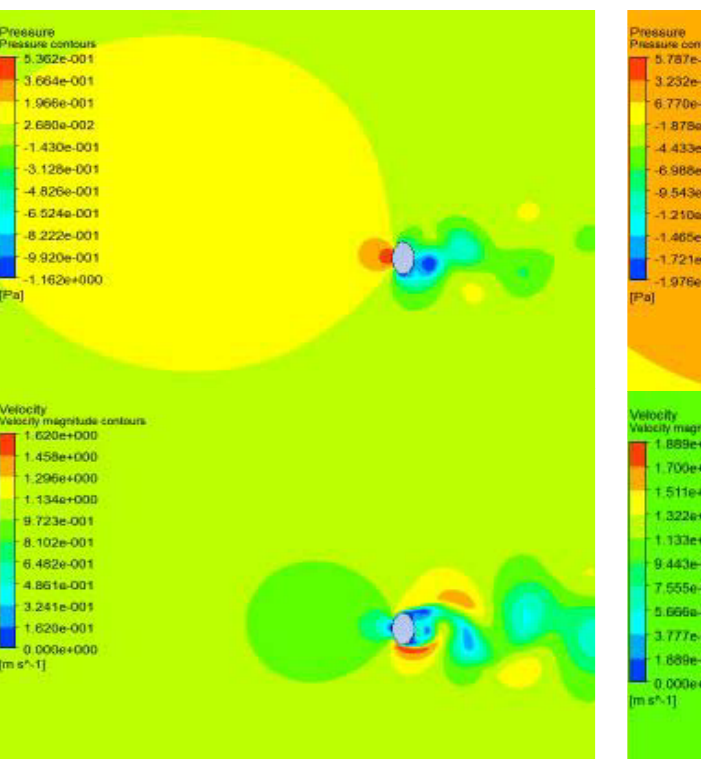
Fig.5. Pressure, velocity for elipse section and Re=200 Further increase of Reynolds number results in a decrease of the distance between the vortices, vortices tear-off time is shorter and wake increases for the circle and ellipse sections (Fig. 6 and 7).